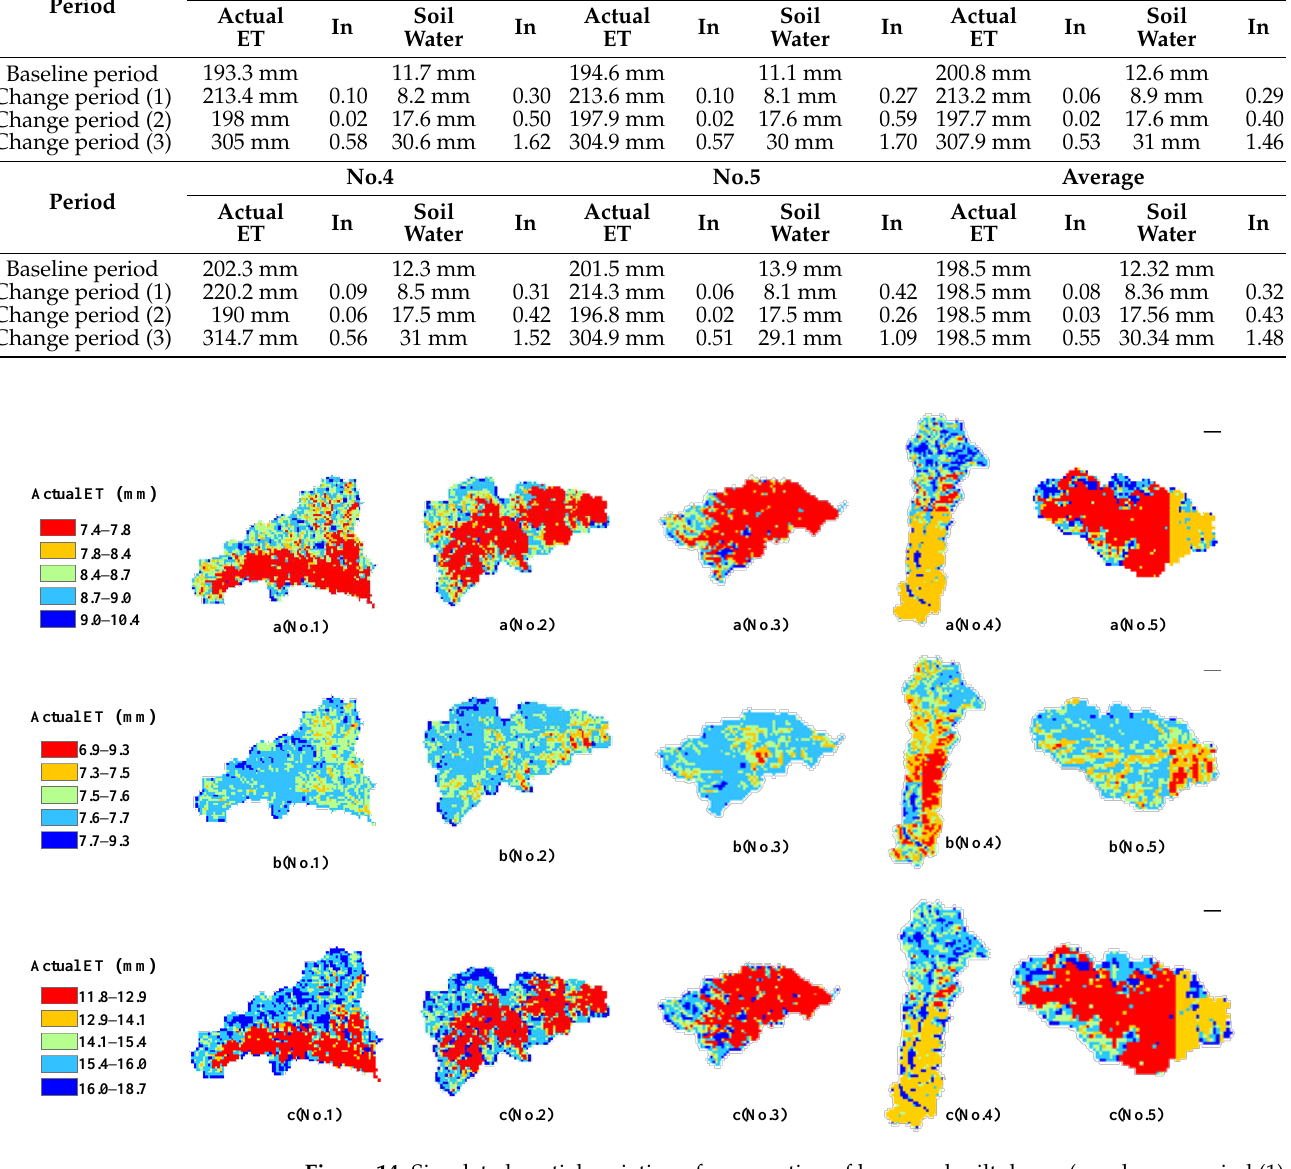
Figure 14. Simulated spatial variation of evaporation of large-scale silt dams. (a = change period (1); b = change period (2); c = change period (3)).